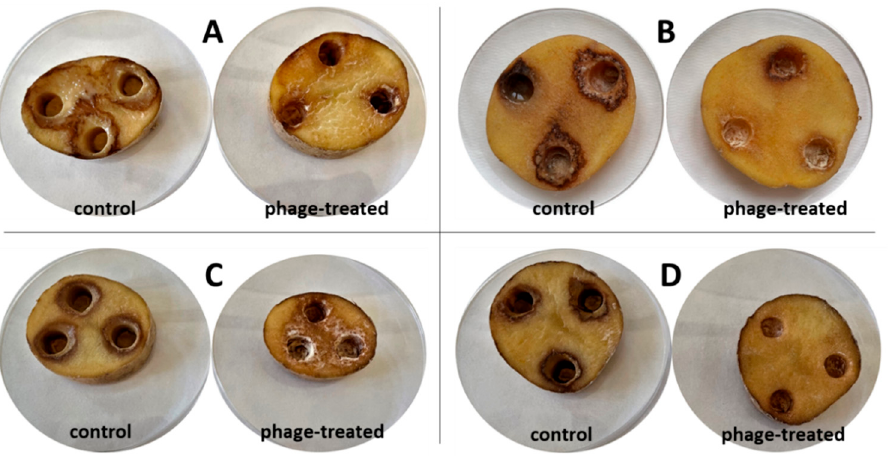
Figure 3. Bacterial rot on potato slices after 72 h of storage at 25 °C; ( A ) D50; ( B ) D200; ( C ) P87; ( D ) P224.